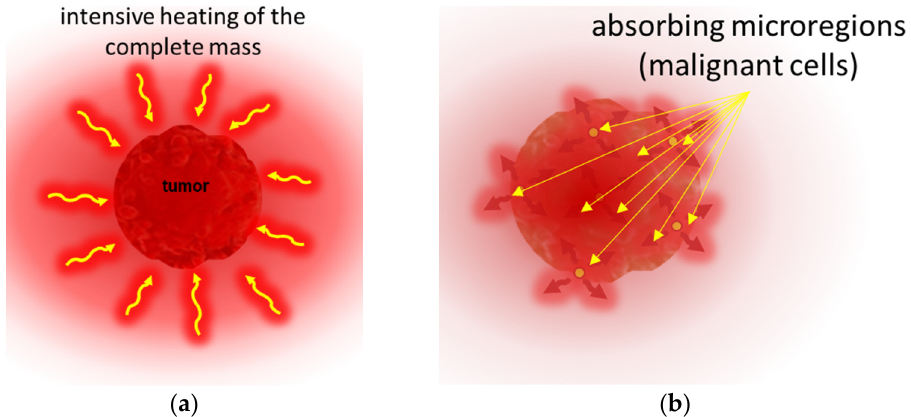
Figure 4. Draft presentation of the heating paradigms: ( a ) Homogeneous mass heating trying to achieve isothermal conditions. It intensively heats the surrounding healthy tissues as well. ( b ) Selective, heterogeneous (heterothermal) heating. It creates a high temperature in the absorbing points, but mild average temperature (<40 °C) in the surrounding healthy tissue.